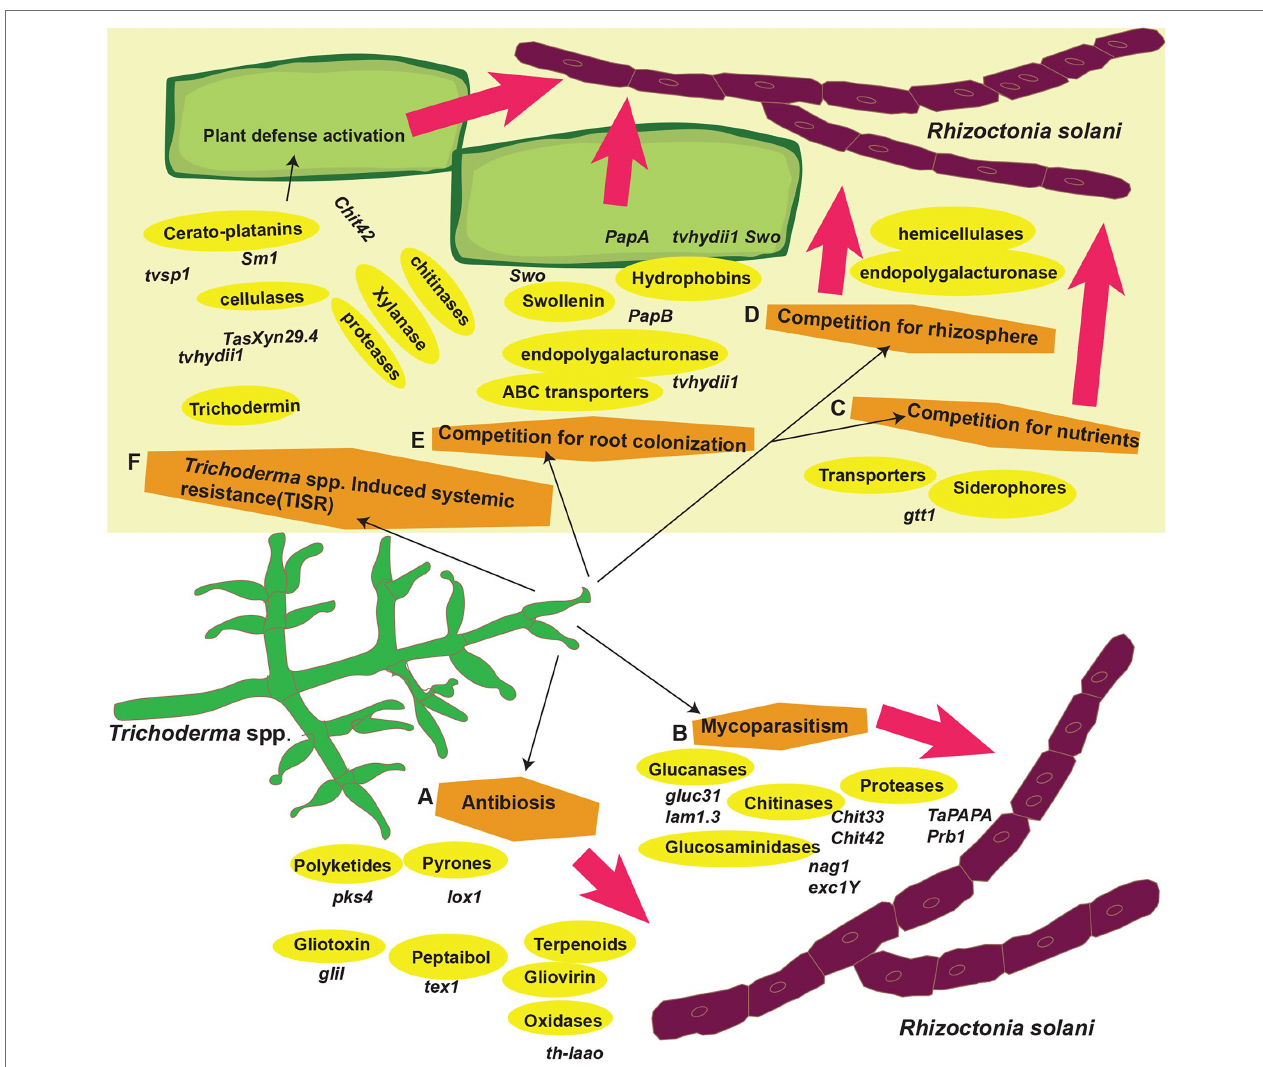
FIGURE 2 | Trichoderma spp. biocontrol mechanisms against R. solani . (A) Trichoderma spp. genes in antibiosis, (B) mycoparasitism, (C–E) competition for root colonization, rhizosphere and nutrients, and (F) induced systemic